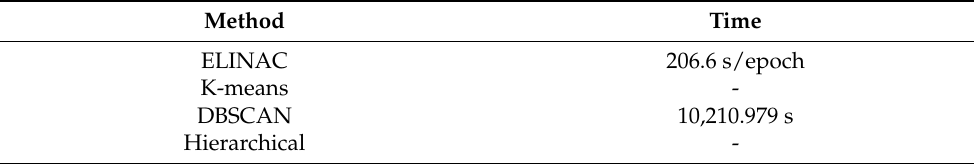
Table 6. Clustering times for the 1 million NF-es dataset.